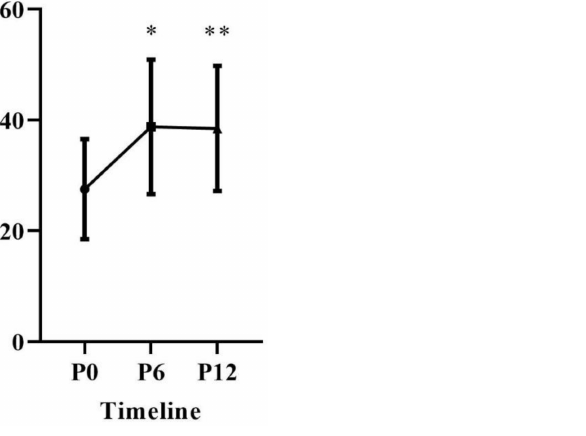
Figure 2. Blood concentration of 25 (OH) D over 12 months of supplementation. * Differences between P0 vs. P6, p = 0.0001. ** Differences between P0 vs. P12, p =